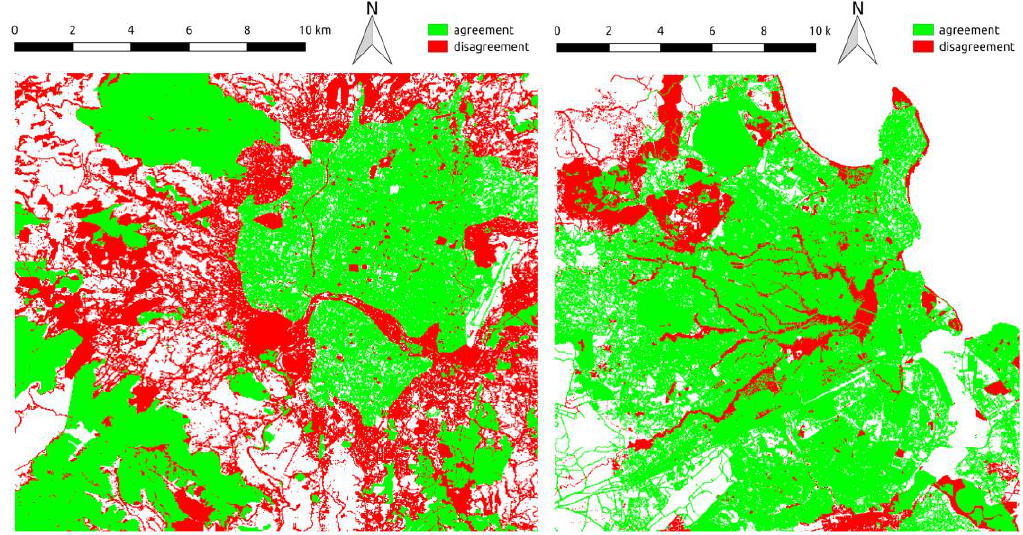
Figure 7. Disagreement maps between the original GL30 and the OSM-derived LULC map for Kathmandu ( left ) and Dar es Salaam ( right ).